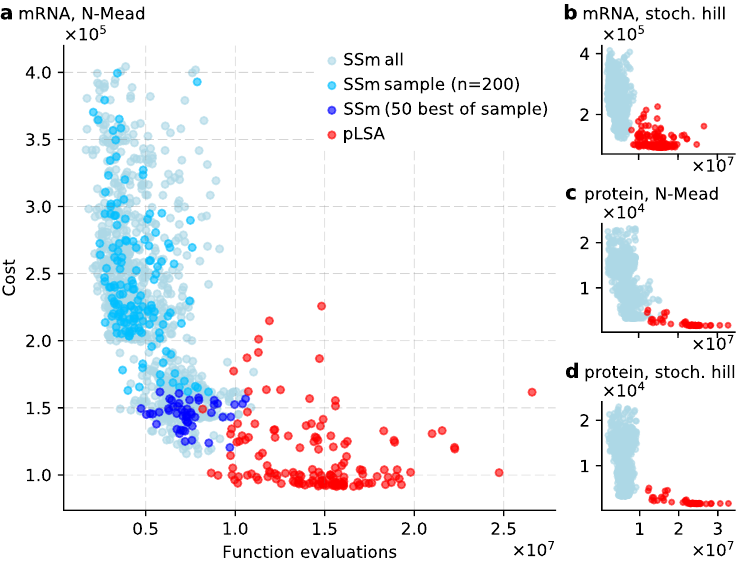
Figure 4. Performance of (sequential) scatter search method (SSm) and parallel Lam simulated annealing (pLSA). All panels plot function evaluations against cost (see Equation (3)). A function evaluation is defined as computing gene expression levels of a gene circuit from time t = 0.0 to 71.1 min. It is a performance measure independent of compiler settings and hardware. The cost indicates how well a gene circuit reproduces gap gene expression data (lower is better). ( a ) The main body of results is based on gene circuits derived from mRNA expression data, using scatter search with the Nelder-Mead algorithm as a local search method. Gene circuits from SSm are grey blue, the 200 selected circuits are blue, of which the 50 best in dark blue. Gene circuits from pLSA are red; ( b – d ) Gene circuit performance using mRNA and protein data expression data, and switching between Nelder-Mead and stochastic hill climbing. Circuits from scatter search are grey-blue, those from pLSA are